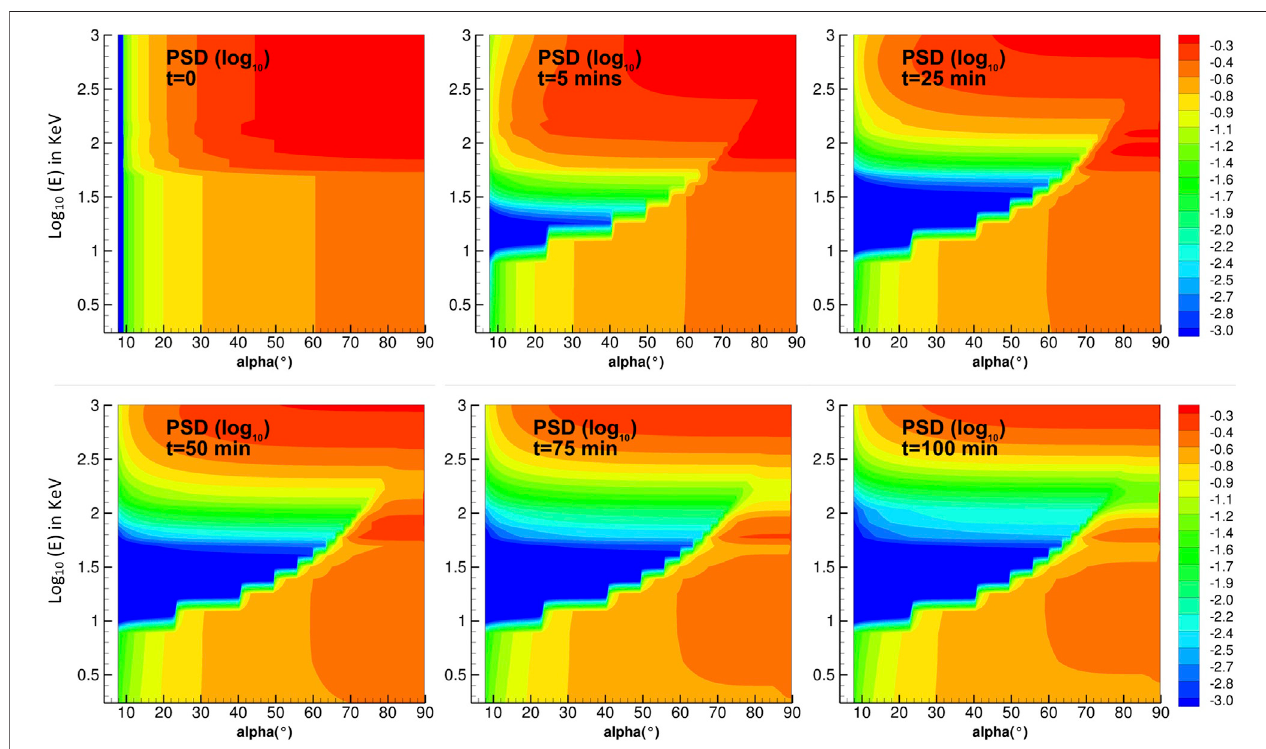
FIGURE6| Phasespacedensityversusenergy(log10inkeV)andequatorialpitchangle(degrees)plottedat t (cid:1) 0,5,25,50,75,100 min.ThisPSDisthesolutionof the Fokker-Planck pitch angle diffusion equation.